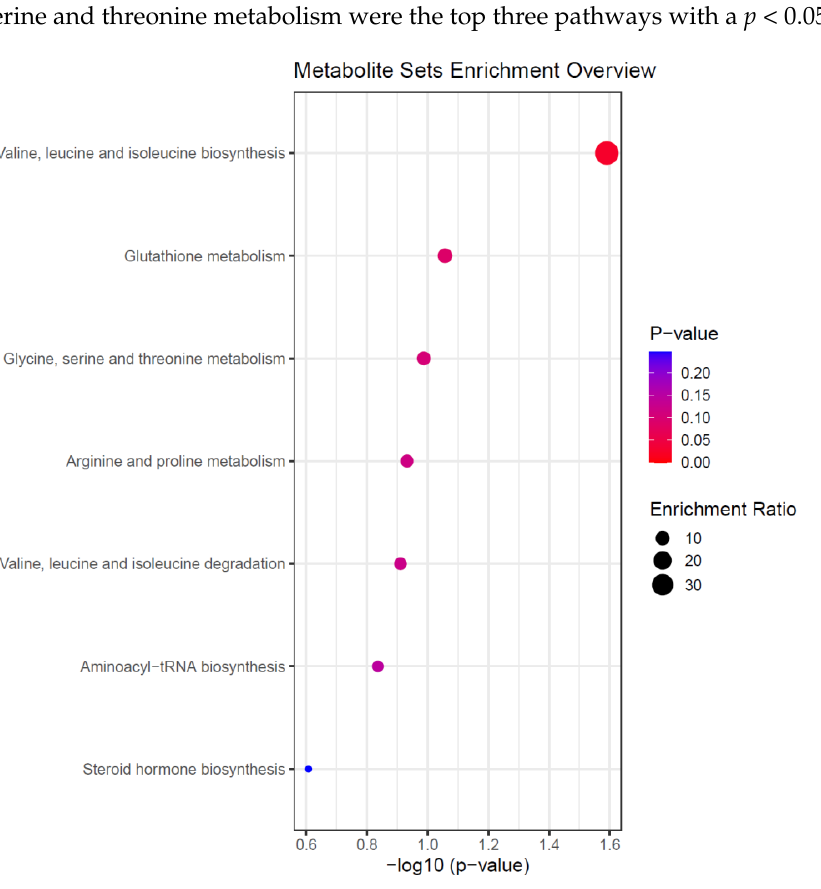
Figure 4. Summary of the altered metabolic pathways in patients with an ICU LOS ≥ 10 days. Data were derived from enrichment analysis of the nine selected metabolites from our PLS-DA model for discriminating between patients with an ICU LOS < 10 or ≥ 10 days. Enrichment Ratio is computed by Hits/Expected, where hits = observed hits; expected = expected hit.